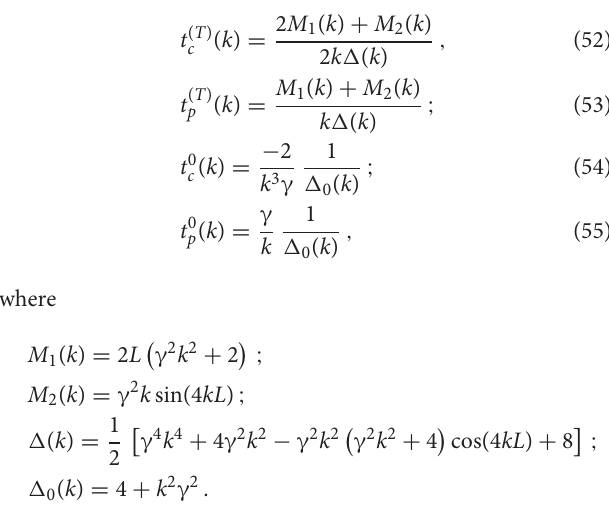
Frontiers in Physics | www.frontiersin.org